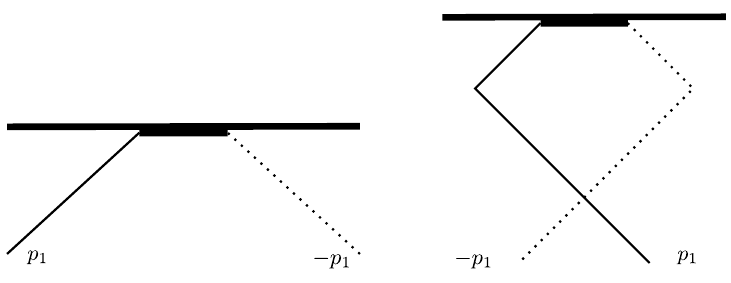
Figure 2 . Coleman-Thun diagrams for the poles of the ground state K-matrix. They correspond to a boundary bound state pole in the direct and one in the crossed diagram indicated by a thicker boundary